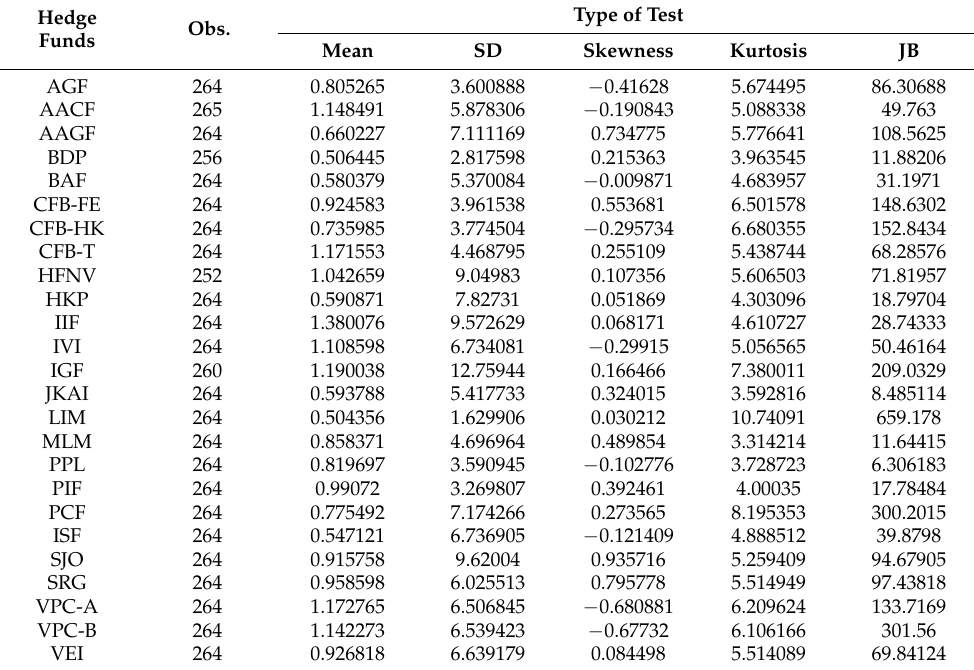
Table A2. Descriptive Statistics of Hedge Fund